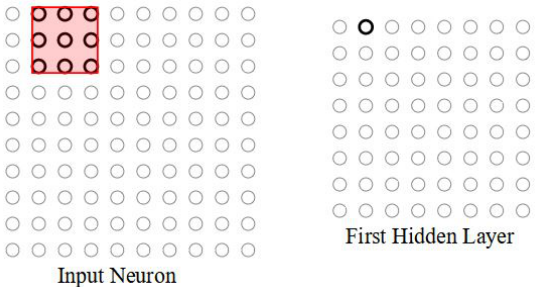
Figure 3. Local receptive field is slid over by one pixel to the right (i.e., by one neuron), to connect to a second hidden